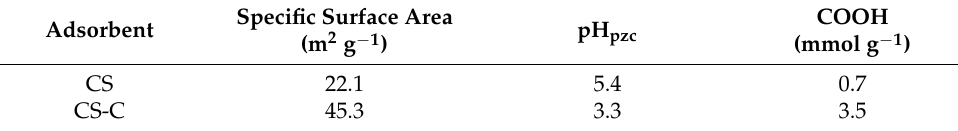
Table 2. Characteristics of CS and CS-C